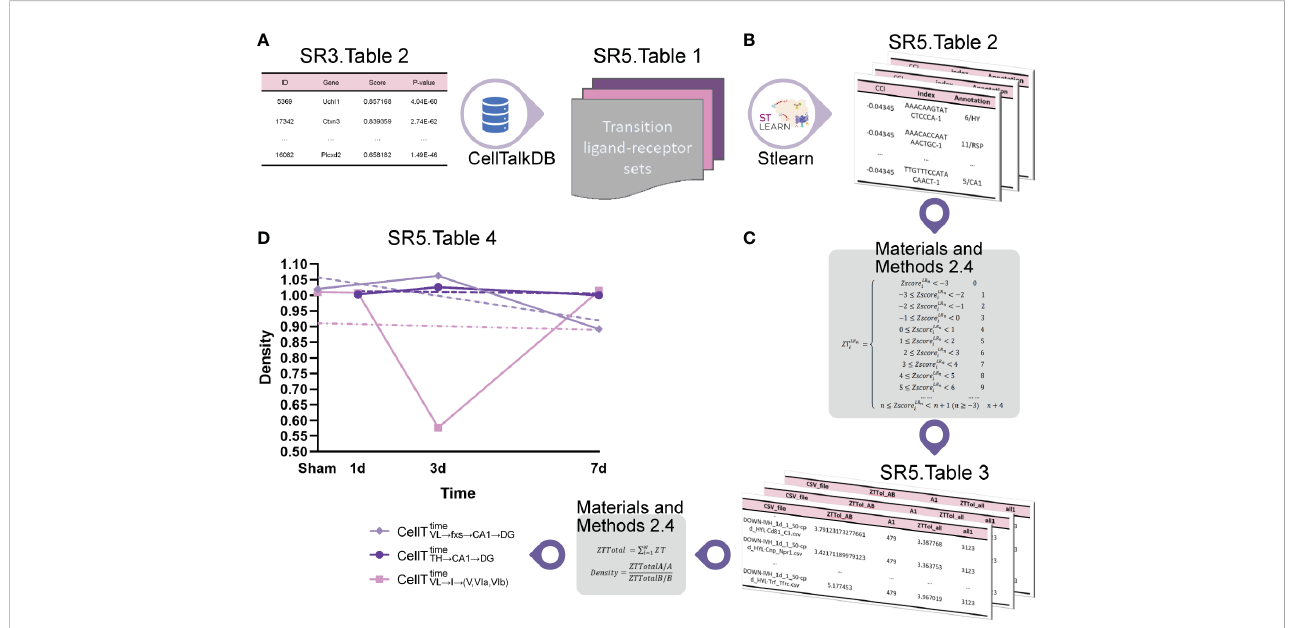
Cell − cell communication strength analysis. (A) The transition ligand – receptor sets. (B) The interaction intensity value Z score LR n i . (C) The discrete interaction intensity value ZT LR n i . (D) The cell − cell communication strength